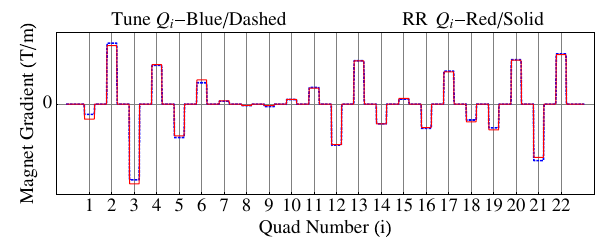
FIG. 9. New magnet settings after optimization.